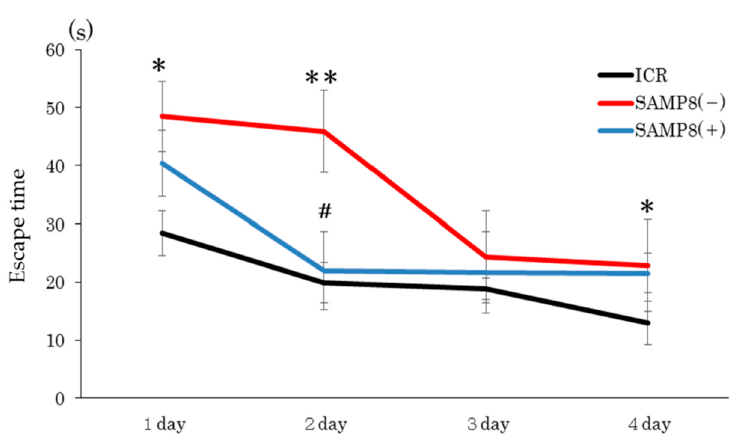
Figure 1. Effects of Coriandrum sativum seed extract on the performance of a spatial memory test in ICR and SAMP8 mice. Values are expressed as the mean ± SEM. An asterisk indicates a significant difference compared to the ICR group (* p < 0.05; ** p < 0.01). A hash mark (#) indicates a significant difference compared to the SAMP8( − ) group. ICR, Institute of Cancer Research; SAMP8( − ), SAMP8 mice without C. sativum supplementation; SAMP8(+), SAMP8 mice with C. sativum supplementation.